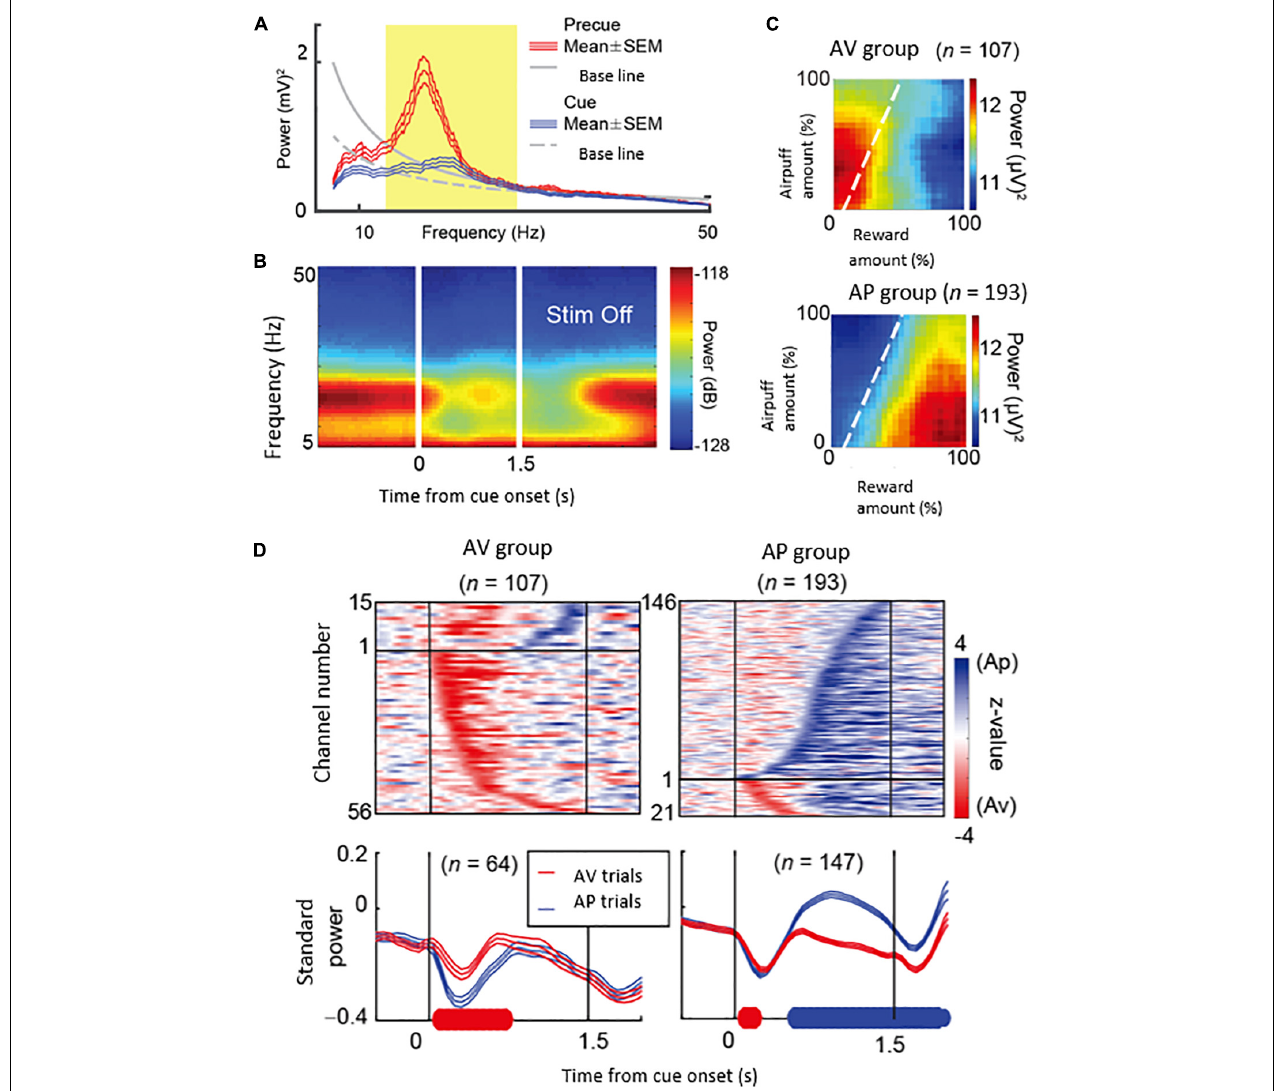
FIGURE 7 | Beta oscillations in the striatal local field potentials (LFPs) encode approach-avoidance decision (Adapted from Amemori et al., 2018). (A) Spectral intensity in precue (red) and cue (blue) periods and baseline (gray). Yellow shading represents the range of beta oscillations. (B) A group of beta oscillations responding to the Ap-Av task. Spectrogram in which time 0 indicates the start of cue presentation. (C) Beta oscillations related to emotion during cue period. Av group (top) appeared in avoidance decisions. Ap group (bottom) appeared in approach decisions. The X-axis indicates the amount of rewards presented (length of the red bar) and the Y-axis indicates the intensity of punishment presented (length of the yellow bar). The color changes indicate the strength (power) of beta oscillations. The dotted line shows the boundary of Ap-Av decision-making. (D) Onset of beta response in cue period. Top: Time change of information representation (power difference, z -value) for Ap (blue) and Av (red). Ap group (right) and Av group (left). Bottom: Power of Beta wave. Solid bold line indicates the time period that shows significant differences between Ap and Av trials (red: Av > Ap, blue: Ap > Av, t -test). Av Group expressed value judgment earlier in the cue